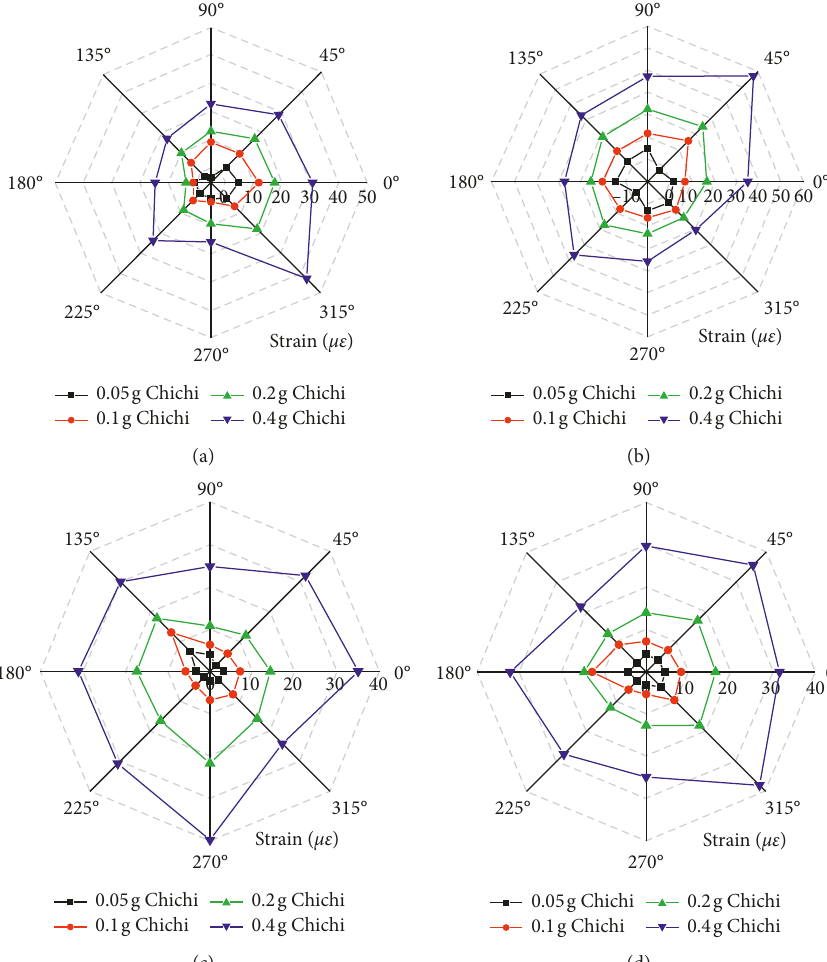
Figure 18: Maximum strains of the model tunnel subjected to different peak acceleration Chichi motions. (a) Inner surface of the tunnel longitudinal. (b) Inner surface of the tunnel hoop. (c) Outer surface of the tunnel longitudinal. (d) Outer surface of the tunnel